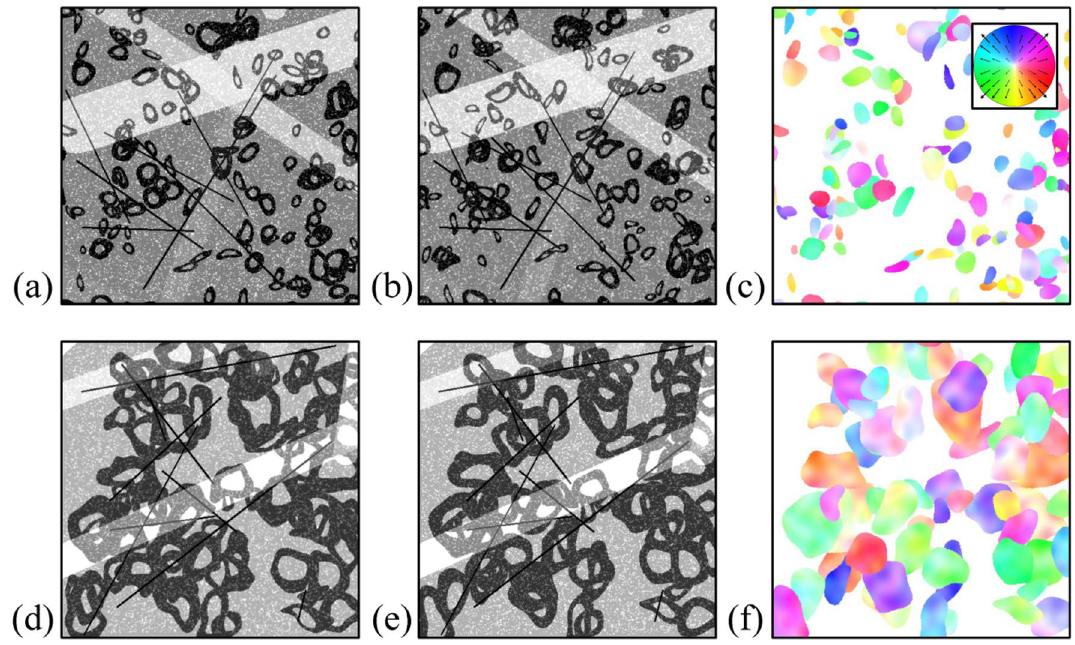
Figure 4. Example of synthetic bubble image pairs used for the fine-tuning dataset for the PWC-Net: ( a,b ) small bubbles (bubble size = 10–60 pixels); ( d,e ) large bubbles (bubble size = 40–130 pixels); ( c,f ) contour of bubble velocity corresponding to each pair. The inset figure in ( c ) shows the direction and magnitude of velocity, expressed in terms of the hue and saturation,